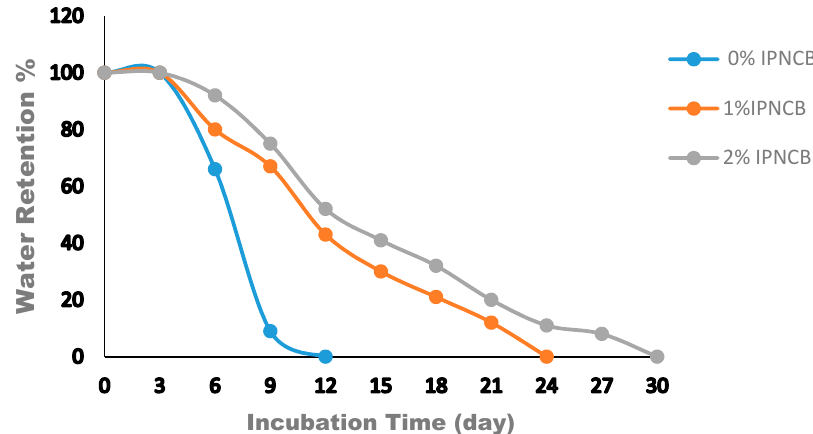
Figure 10. Effect of BC ratio (%) on water retention (WR).